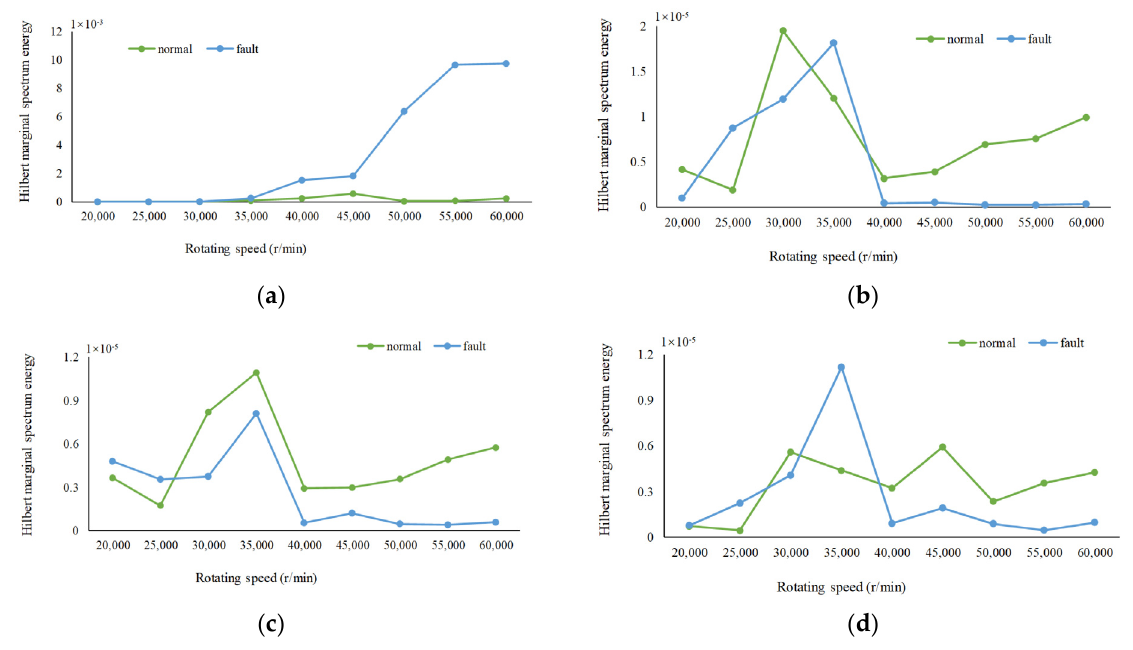
Figure 8. The Hilbert marginal spectrum energy distribution ( a ) IMF1; ( b ) IMF2; ( c ) IMF3; and ( d )